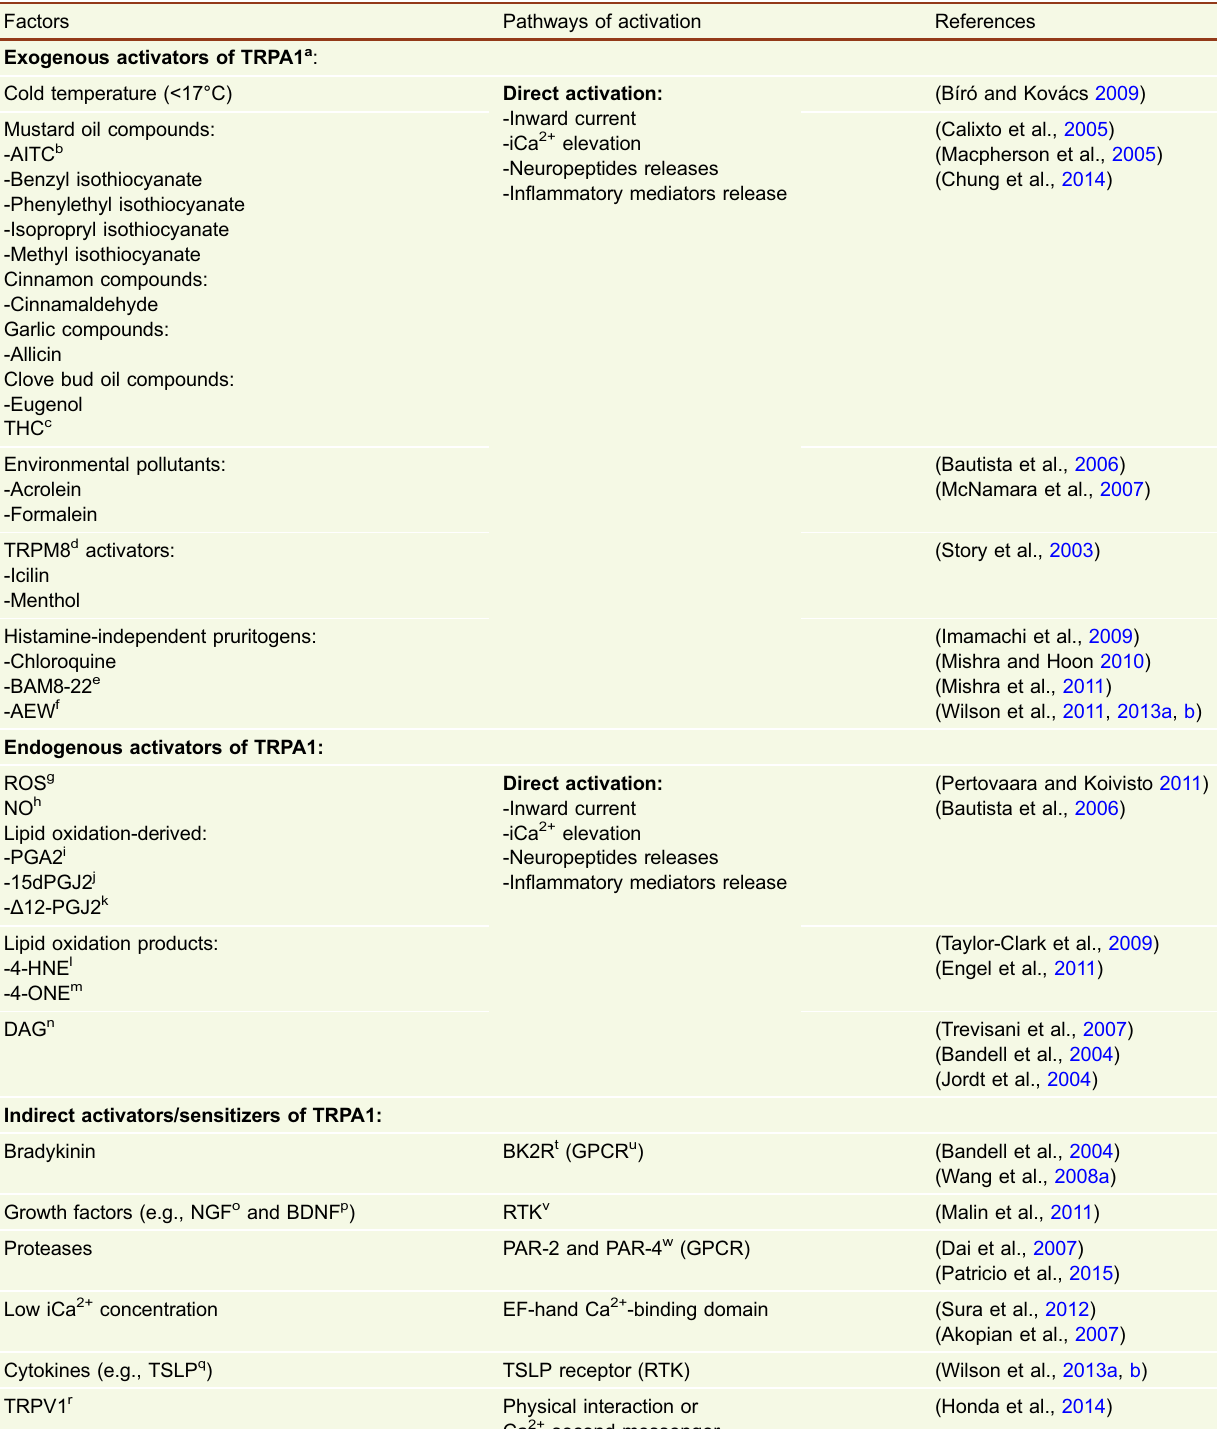
Table 2. Endogenous and exogenous agonists involved in TRPA1 activation, sensitization, and